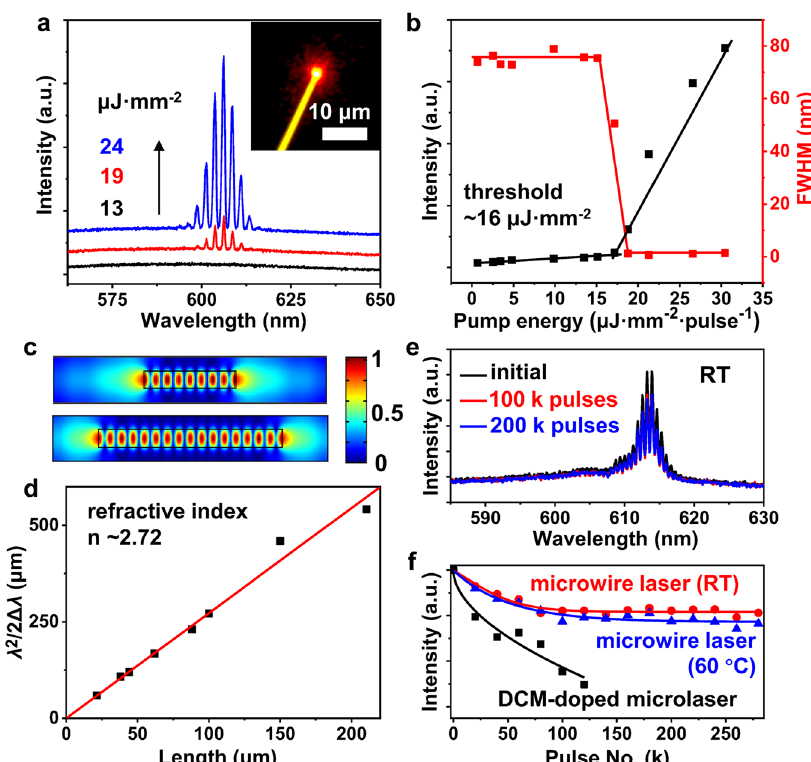
Fig. 3 Lasing properties of BPCBT microwires. a Emission spectra from a single BPCBT microwire under different pump fl uences of a 400 nm pulsed laser (~200 fs, 1 kHz). Inset is optical microscopy image of microwire tip. b Emission intensity (black) and FWHM (red) as a function of pump energy. c Electric- fi eld distributions in the microwires (top, 1- μ m length; bottom, 2- μ m length) as FP-type optical resonators. d Plots of λ 2 /2 Δ λ versus the length of microwires and the linear fi t according to FP-type resonance. e Lasing spectra of microwire at initial state, after 100 k pulses and 200 k pulses at RT. f Lasing intensities of microwire at RT and 60 °C during a series of excitation laser pulses. The DCM-doped microsphere laser was used as a control